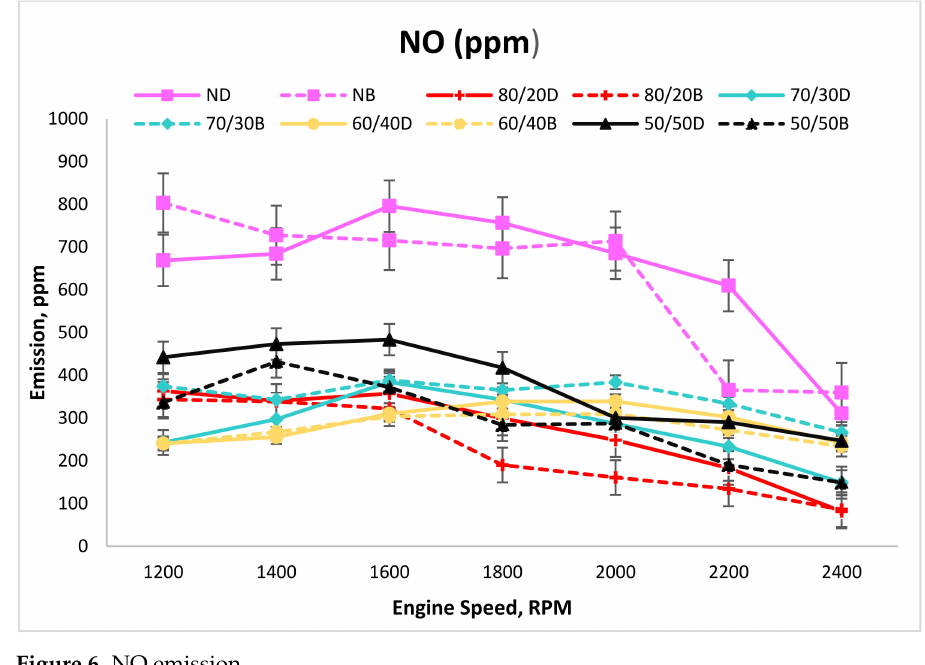
Figure 6. NO emission.